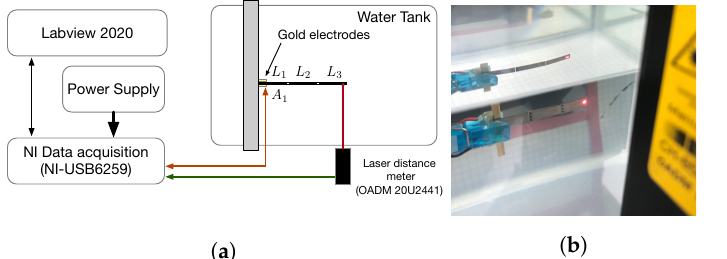
Figure 4. Experimental setup: ( a ) scheme, ( b ) swimming robot prototype pointed by the laser distance meter during an experiment.